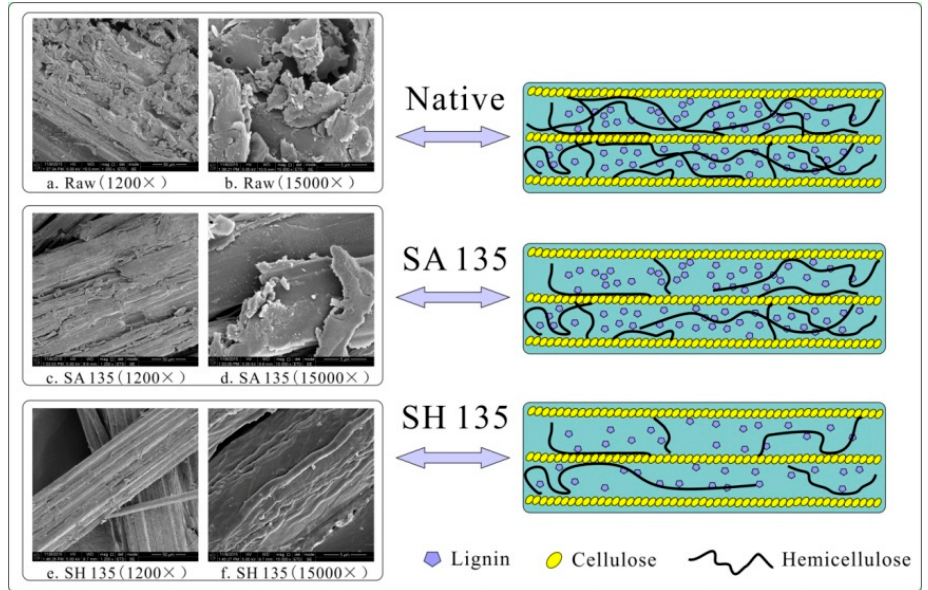
Figure 5. Scanning electron microscopic images of raw bamboo and pretreated bamboo samples. Note: